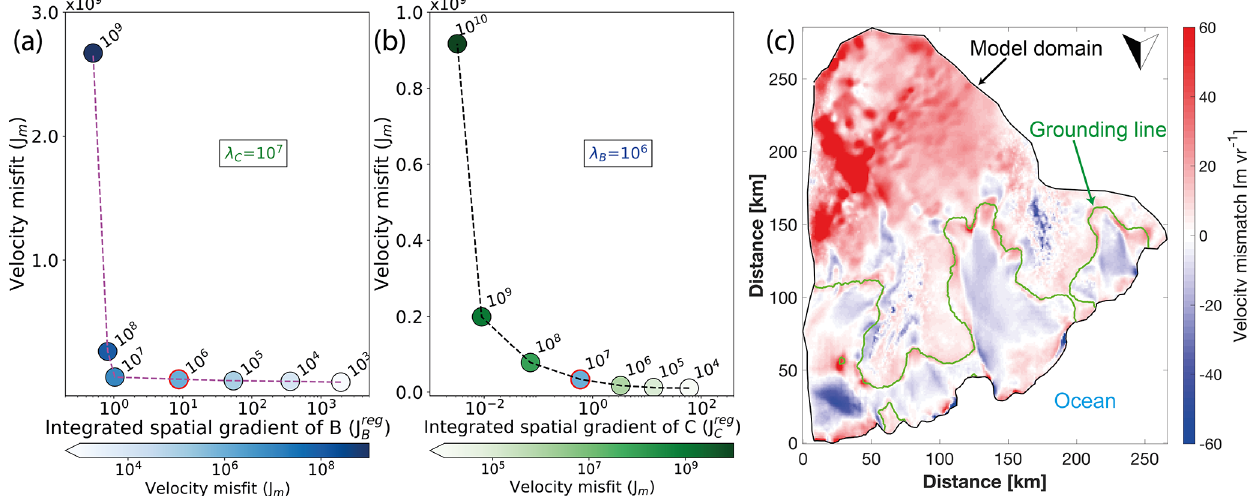
Figure 3. L-curve analysis to select Tikhonov parameters λ B and λ C : (a) 2-D cross section for variable λ B and λ C fixed at 10 7 Pa − 2 m 6 a − 4 . (b) Reverse case with constant λ B at 10 6 m 4 a − 2 and varying λ C . J m (m 4 a − 2 ) and J reg (c) shows mismatch between modelled and observed velocities (Rignot et al., 2011) after FS inversion for the modelling domain (Fig. 1b, blue